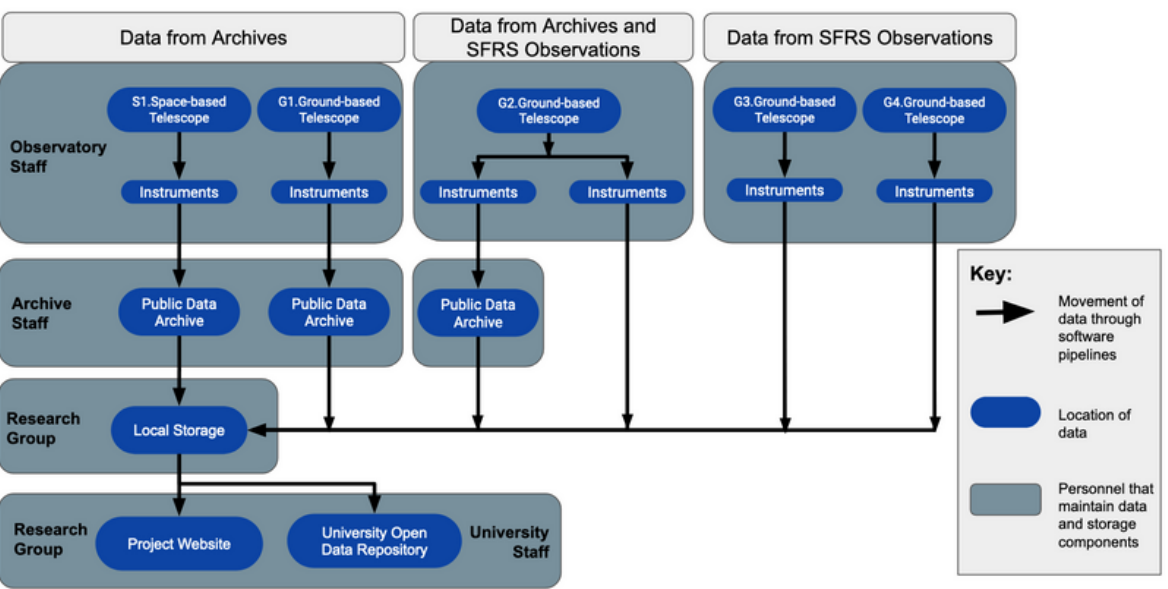
Figure 4. Overview of data processing workflows to create the Star-Forming Region Survey